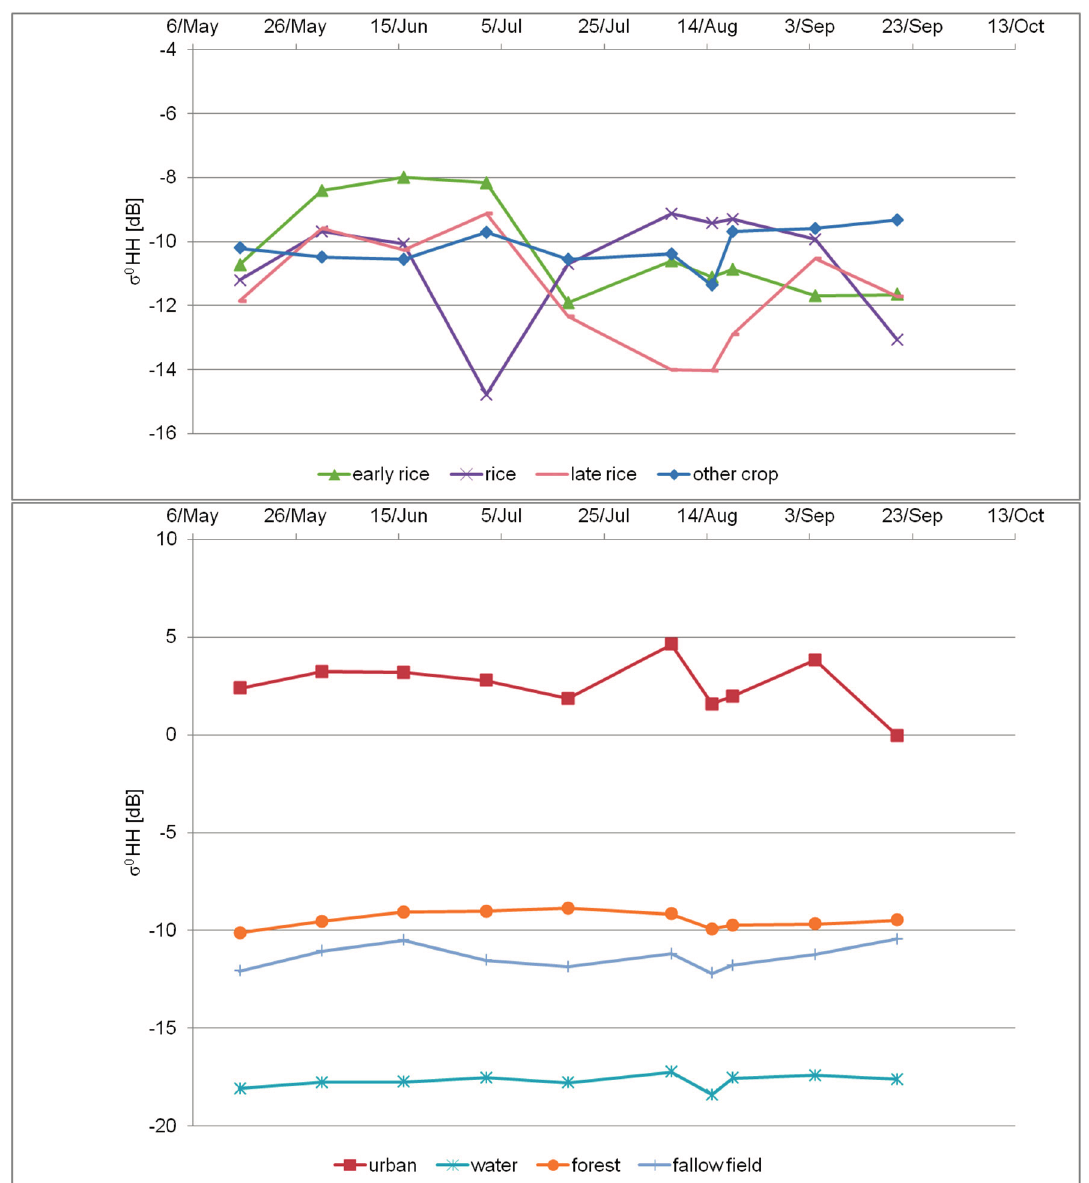
Figure 4. Example temporal signatures from Leyte East in 2013 showing different rice classes ( top ) and other land uses ( bottom ) from one season of CSK X-band SAR data, HH polarization and 46-degree incidence angle. Note the different scale in the vertical